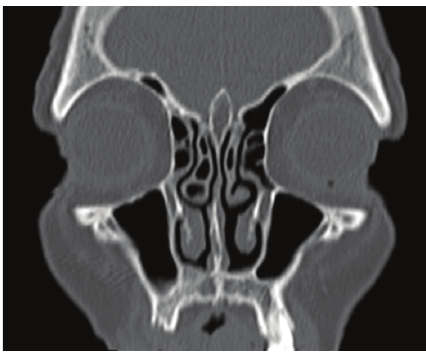
Figure 1: Coronal CT scan showing two thin bony septums inside the CB cavity and hypertrophy of inferior turbinate in the right side, besides lamellar type CB in the left